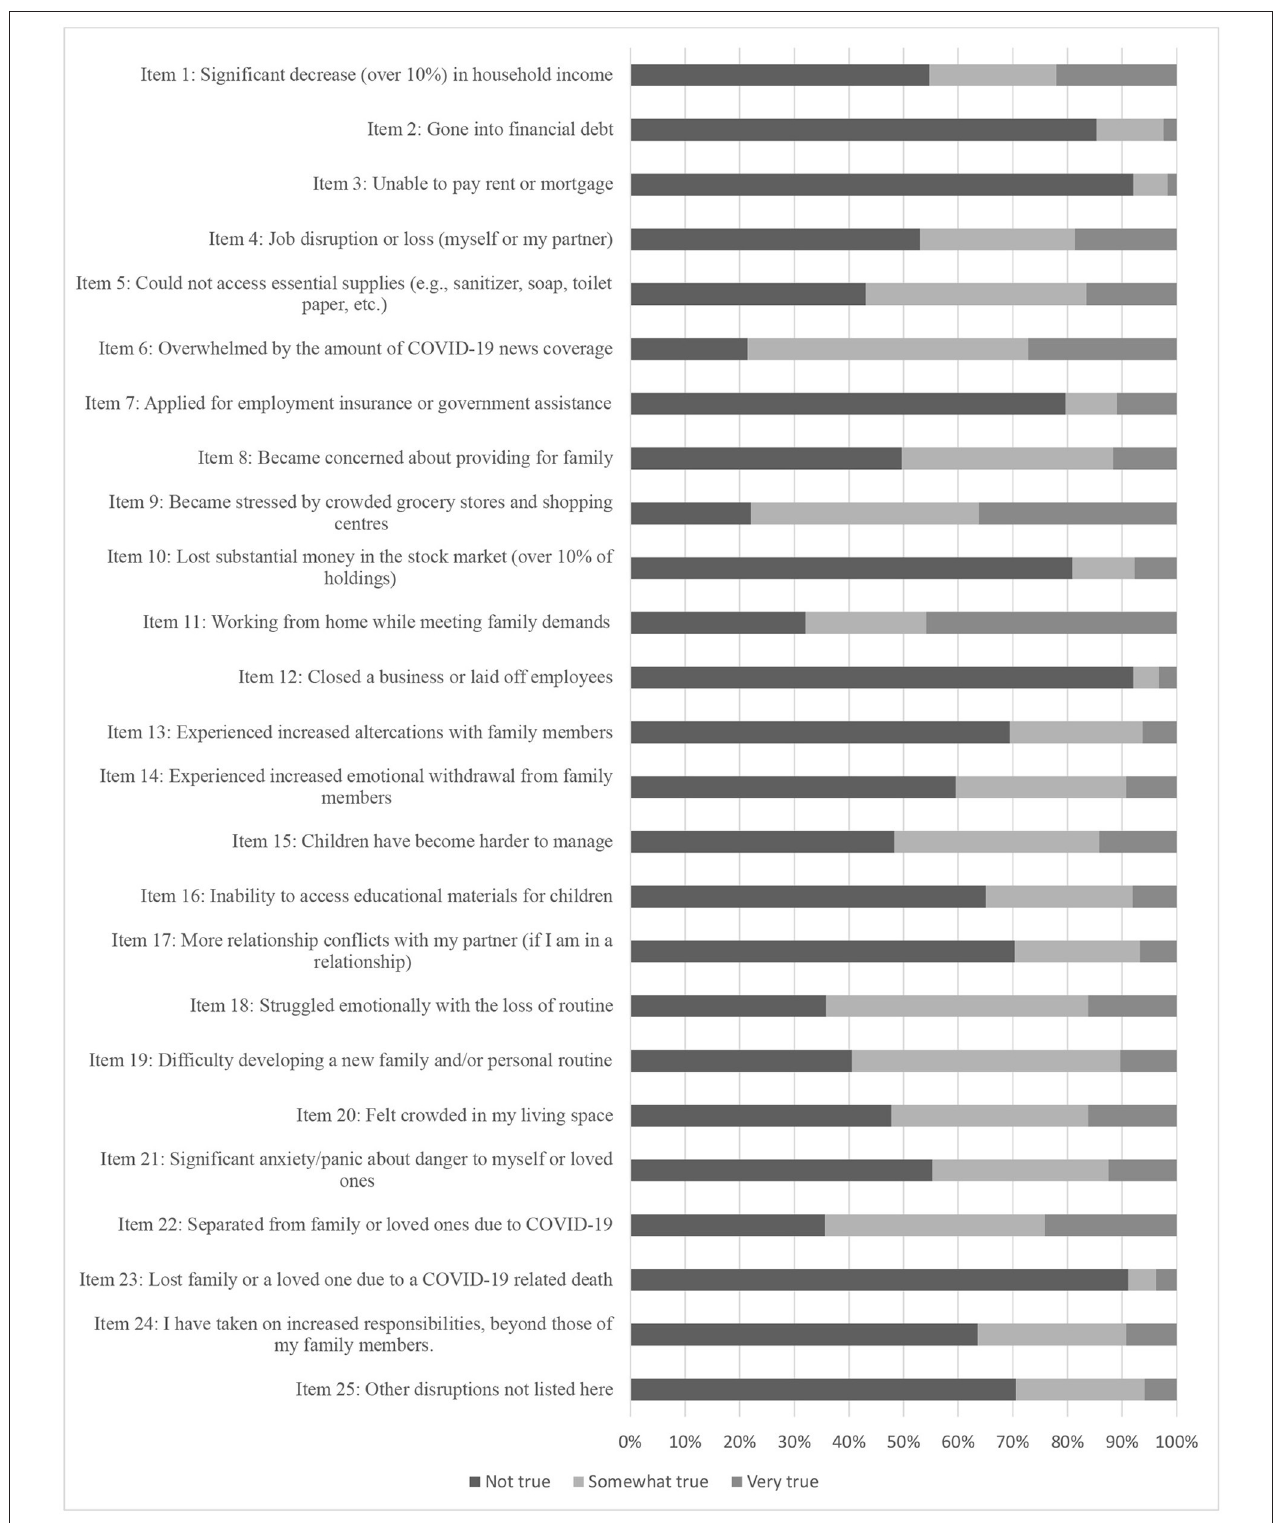
FIGURE 1 | Distribution of responses on individual scale items of the COVID-19 Family Stressor Scale.